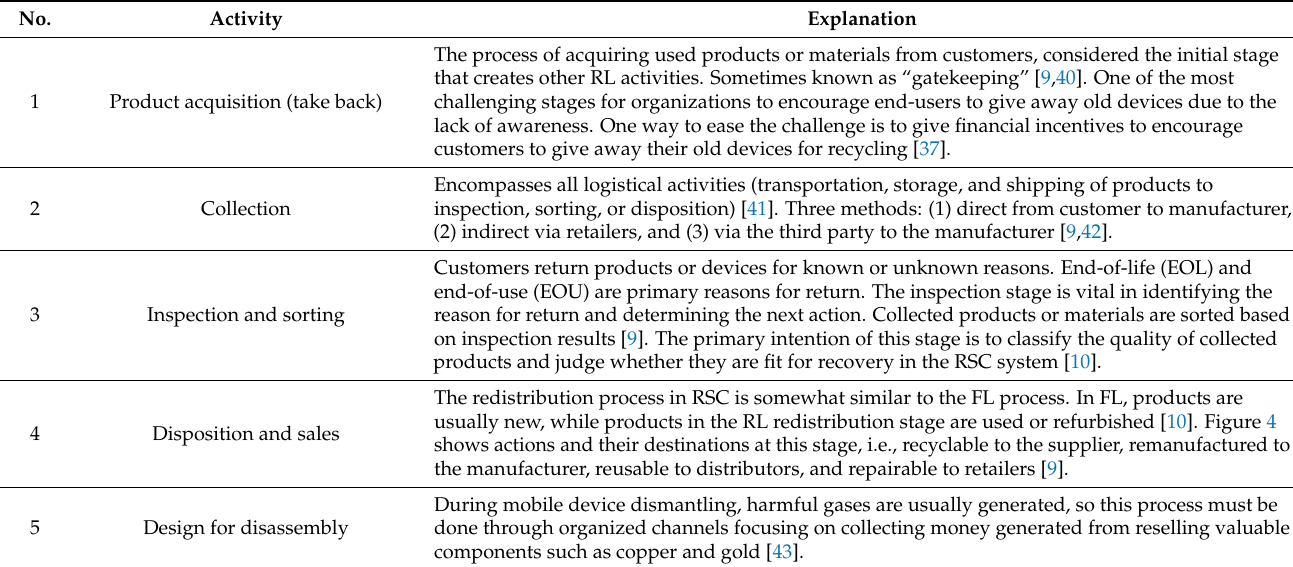
Table 2. Explanation of reverse supply chain (RSC) activities according to major